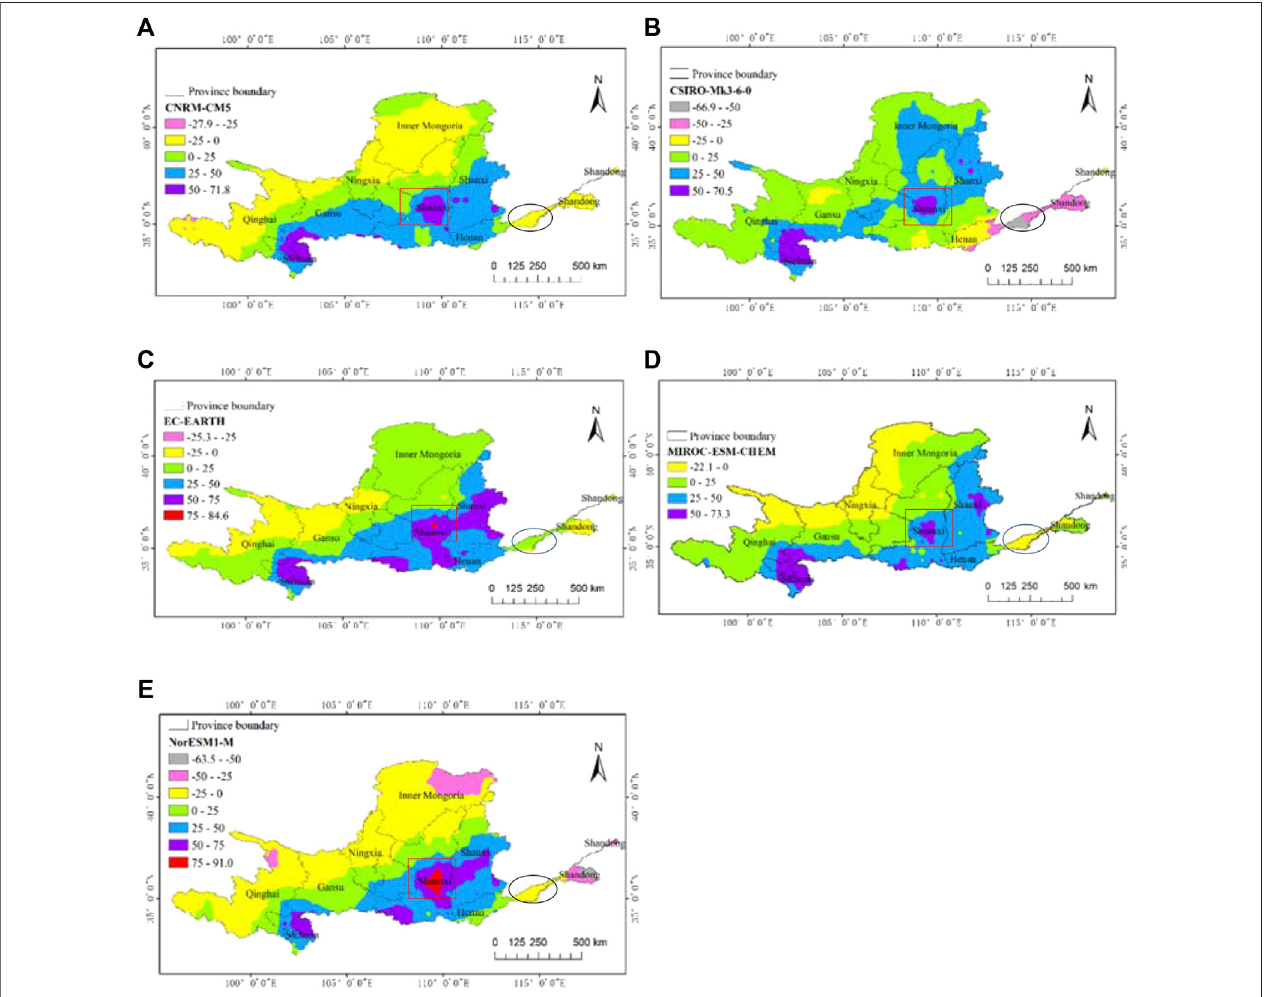
FIGURE 5 | Annual total precipitation deviations of the fi ve CMIP5 models with observations in 1986 – 2005 (mm, positive deviation means overestimation; minus means underestimation). (A – E) represents fi ve CMIP5 models of (A) CNRM-CM5, (B) CSIRO-Mk3-6-0, (C) EC-EARTH, (D) MIROC-ESM-CHEM, (E) NorESM1-M.